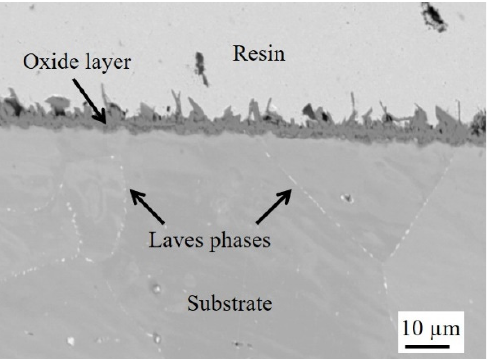
Figure 3. Backscattered electron image of the cross section of the polished sample after 100 h aging at 800 °C under laboratory air.